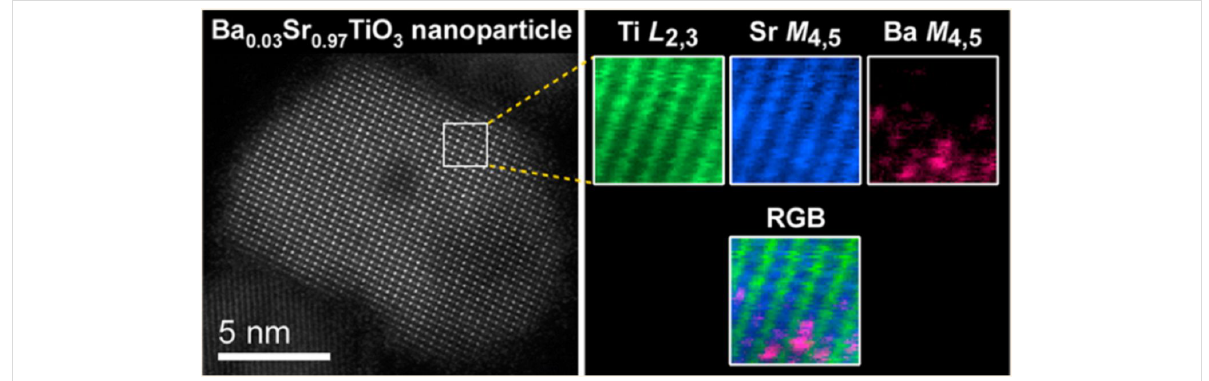
Figure 5: An atomic-resolution chemical mapping of Ba-doped SrTiO 3 nanoparticles: (a) the HAADF-STEM image of a Ba-doped STO nanoparticle along the [011] direction; (b) the simultaneous chemical mappings measuring the Ti_L 2,3 , Sr_M 4,5 , and Ba_M 4,5 edges, respectively, and the corres- ponding RGB map. Reprinted with permission from [49]. Copyright (2012) The American Chemical Society.